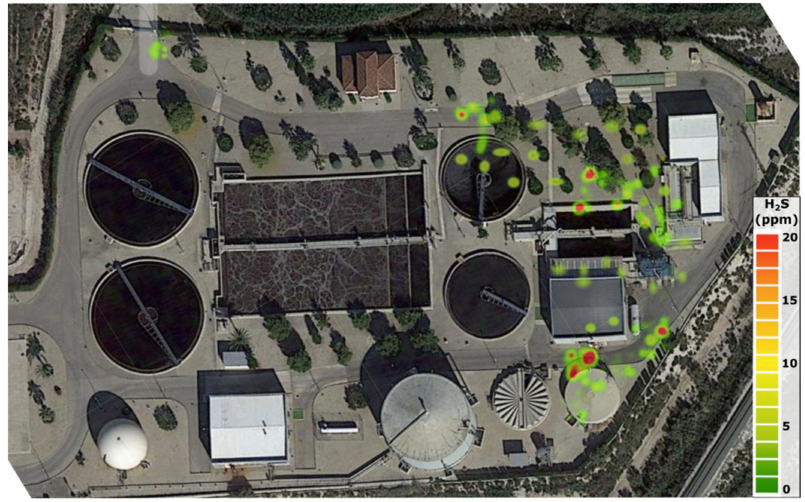
Figure 7. Map of H 2 S concentration obtained from drone measurements.